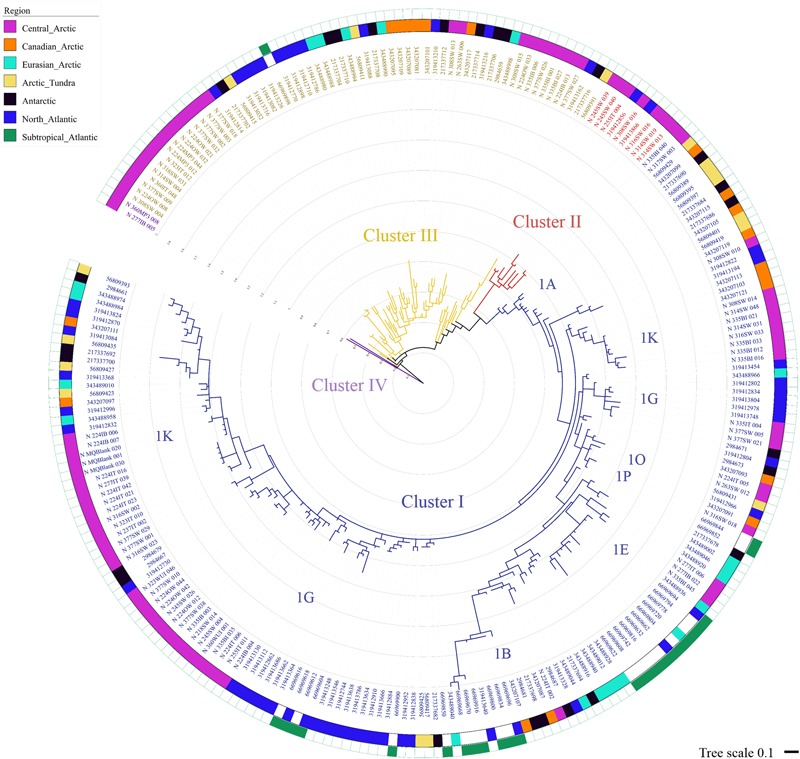
Maximum likelihood phylogenetic tree of nifH partial amino acid sequences including sequences from the Central Arctic (this study), as well as other oceanic regions and similar cold environments. Maximum likelihood tree of the 243 representative sequences clustered using CD-HIT EST (Li and Godzik, 2006) at 97% nucleotide similarity (Turk-Kubo et al., 2014) built using RAxML V8.1. The best performing model was the WAG matrix substitution model and we performed 1000 bootstraps. The tree and its associated metadata were visualized using iTOL (Letunik and Bork, 2007). The colored strips indicates the origin of the sequences represented by each representative sequence shown in the tree. From the 243 representative sequences, 86 contained sequences exclusively from the Central Arctic (pink), 19 from the Canadian Arctic (Blais et al., 2012) (orange), 20 from the coastal Eurasian Basin (Díez et al., 2012) (light blue), 16 from the Arctic tundra (Izquierdo and Nüsslein, 2006) (yellow), from the Antarctic ice shelf (Olson et al., 1998; Jungblut and Neilan, 2010) (black), 51 from the North Atlantic (Turk et al., 2011) (dark blue), and 26 from the subtropical Atlantic (Langlois et al., 2005) (green). Note that the North Atlantic and the Subtropical Atlantic shared five representative sequences and the Eurasian Basin and the Subtropical Atlantic share one. The four clusters of nifH classification are marked in blue (Cluster I), red (Cluster II), yellow (Cluster III) and purple (Cluster IV). Cluster I subclusters (1A, 1B, 1K, 1G, etc) are indicated close to their node.